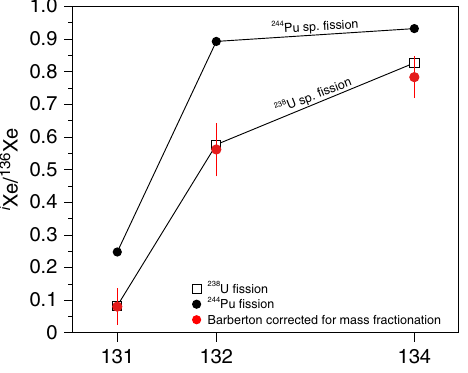
Figure 9 | Fission spectrum of Barberton Xe corrected for mass- fractionation relative to a starting isotopic composition similar to U-Xe. It corresponds to spontaneous fission of 238 U. The fission spectra for fission of 238 U and 244 Pu are from a compilation in ref. 56. Errors at 2 s